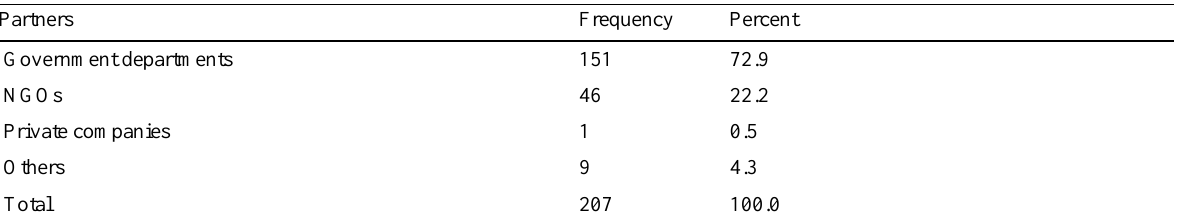
Table 7: CBOs’ partners in Agroforestry